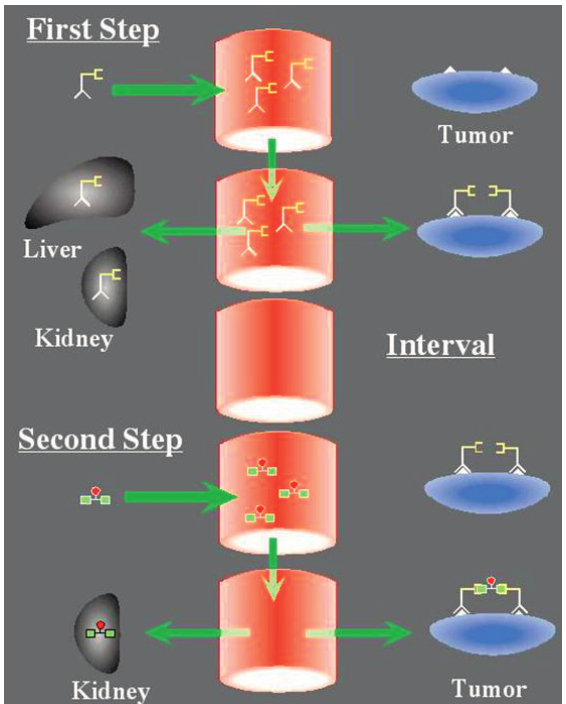
Figure 1. The concept of pretargeting with the Affinity Enhancement System: a bispecific antibody, designed to bind by one arm a tumor antigen (e.g., carcinomembryonic antigen) and by the other a hapten (e.g., the indium-diethylene triamine pentaacetic acid (DTPA) complex or the histamine-succinyl-glutamine (HSG) pseudo-peptide), is injected first. It distributes in the whole-body and targets the tumor cells. After an interval of several